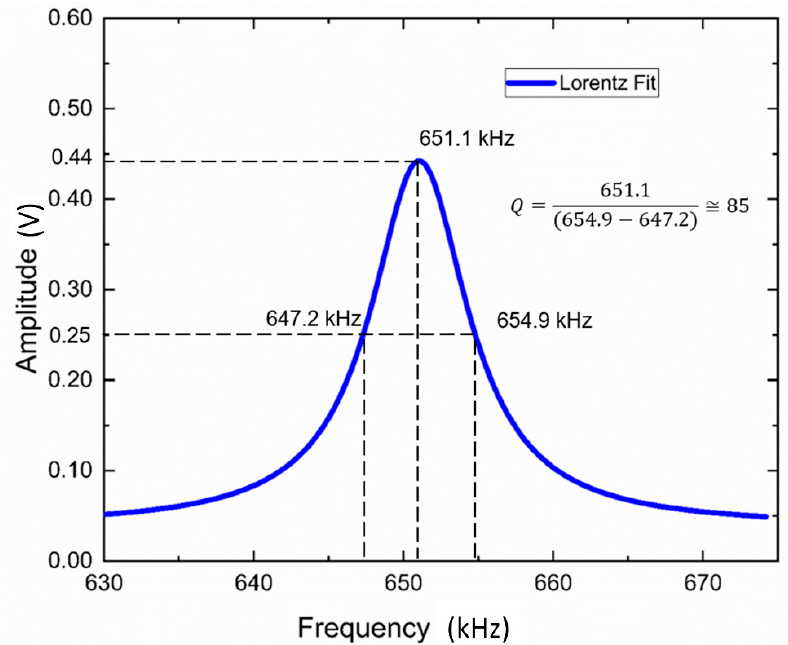
Figure 12. Lorentzian fit of amplitude vs. frequency for the resonance frequency of a MWCNTs with D = 102 nm, L = 12 µ m, E 1 = 82.1 ± 16.4 and ν 1 = 651.1 kHz, where Q = ν 1 ∆ of 10 10 V.